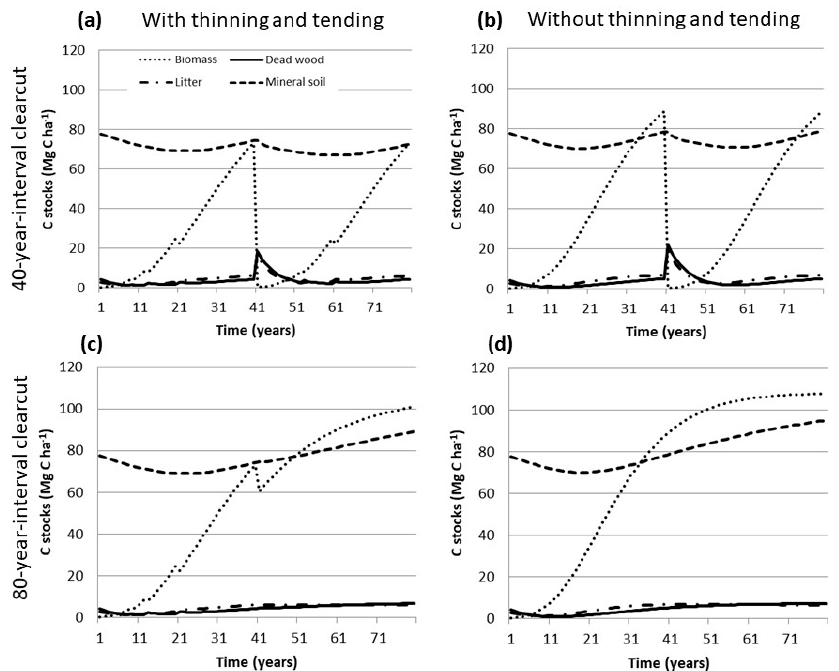
Figure 4. Carbon stock scenarios resulting from the application of the FBDC model for high biomass production forests in South Korea according to ( a , b ) and ( c , d ) cutting age (40 and 80) and ( a , c ) and ( b , d ) with and without thinning and tending during the first 80 years after implementing the forest management. Di ff erent line types represent di ff erent forest carbon pools (biomass, litter, dead wood, management. Different line types represent different forest carbon pools (biomass, litter, dead wood, and mineral and mineral soil).